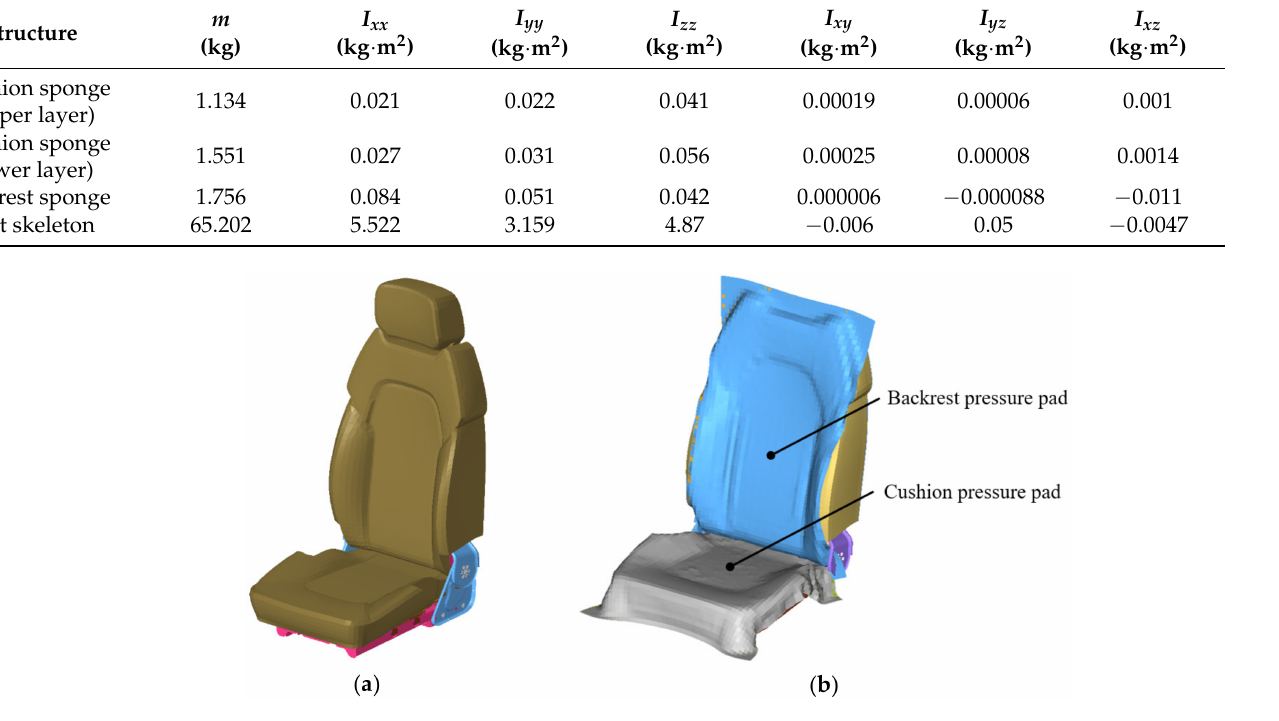
Figure 4. ( a ) The seat finite element model without pressure pad; ( b ) The seat finite element model with pressure